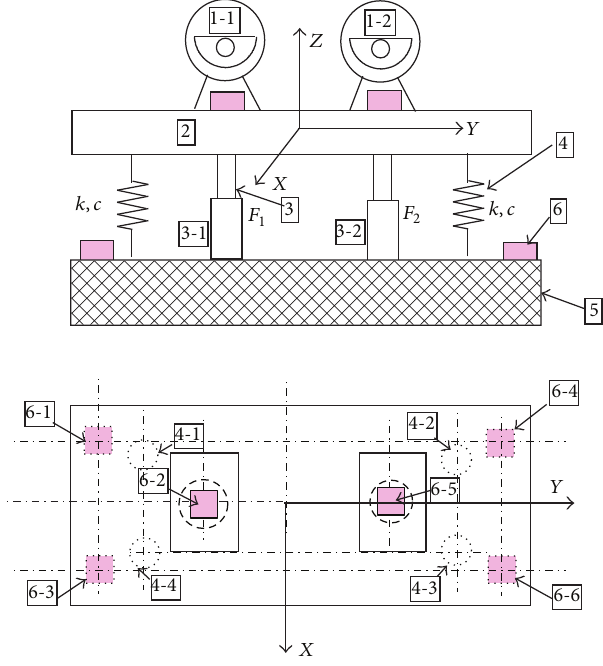
Figure 1: Multisources complex excitations active vibration isola- tion